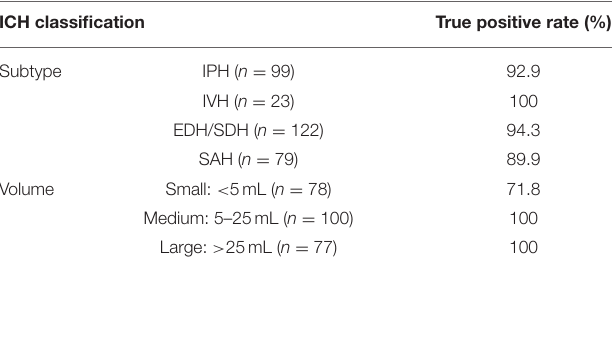
TABLE 4 | True positive rates for ICH cases based on subtype and volume.